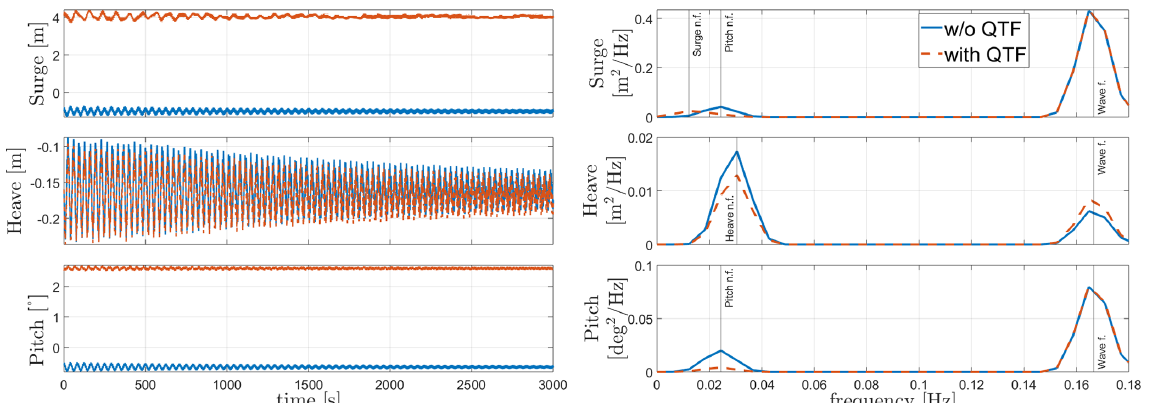
Figure 6. WindCrete’s response to regular waves without and with second-order forces ( T = 6s ,H =